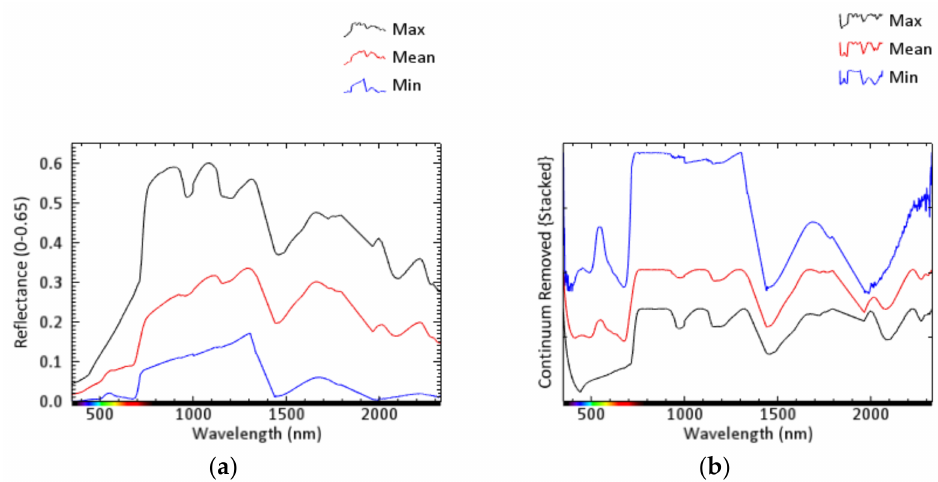
Figure 6. Summary statistics for all spectral data: mean, maximum (Max) and minimum (Min) ( a ) Reflectance, graphed to reflectance 0–0.65 magnitude; ( b ) continuum removed (CR)